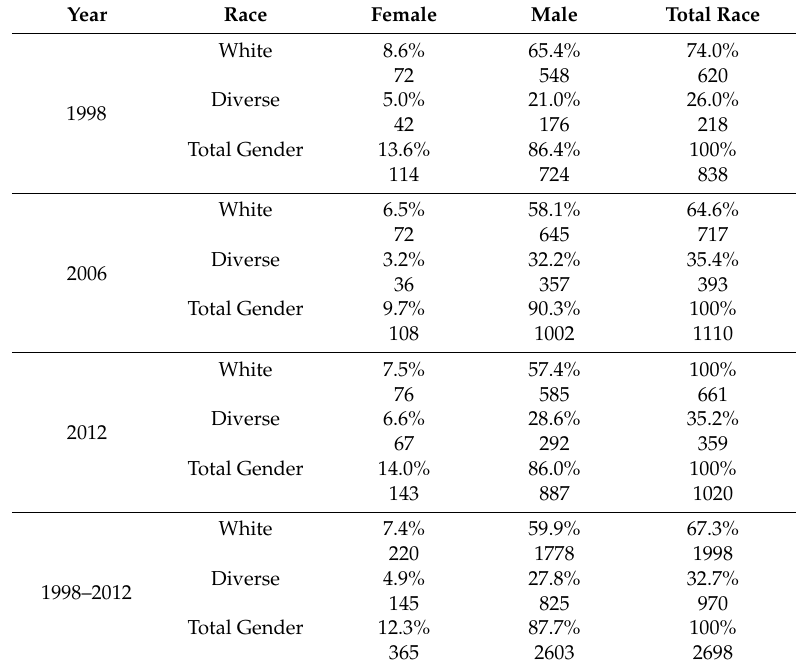
Table 2. Head Clergy Race by Gender over